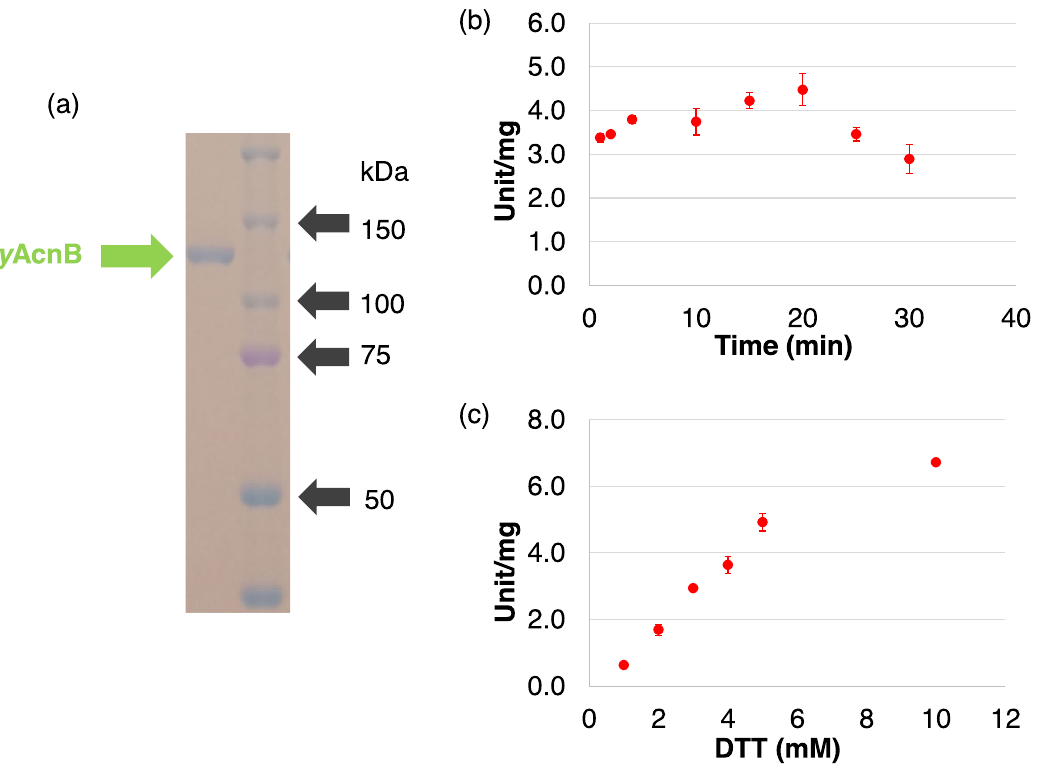
Figure 1. Determination of reactivation conditions for Synechocystis sp. PCC 6803 aconitase B ( Sy AcnB). ( a ) Affinity purification results for GST-tagged Sy AcnB. The purified protein was electrophoresed via 8% SDS-PAGE, and the gel was stained using Instant Blue reagent. ( b ) Effect of reactivation time on Sy AcnB activity. The experiment was performed using 50 pmol of Sy AcnB and 20 mM trisodium citrate dihydrate in Tris–HCl buffer pH 8.0 at 45 °C. Mean ± SD values were calculated from three independent experiments. ( c ) Effect of DTT concentration on Sy AcnB activity. The experiment was performed using 50 pmol of Sy AcnB and 20 mM trisodium citrate dihydrate in Tris–HCl buffer pH 7.7 at 45 °C. Mean ± SD values were calculated from three independent experiments. GST, glutathione- S -transferase; SDS-PAGE, sodium dodecyl sulphate–